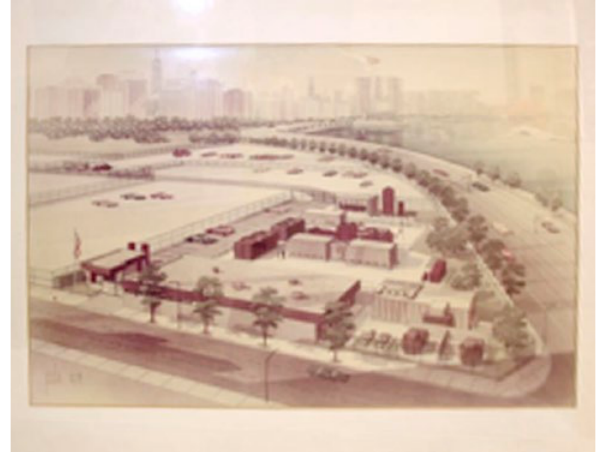
Figure 14. Artist’s rendering of the 4.8 MW Bedford–Stuyvesant fuel cell power plant. NMAH catalog no. 2008.0006.03. Smithsonian image.